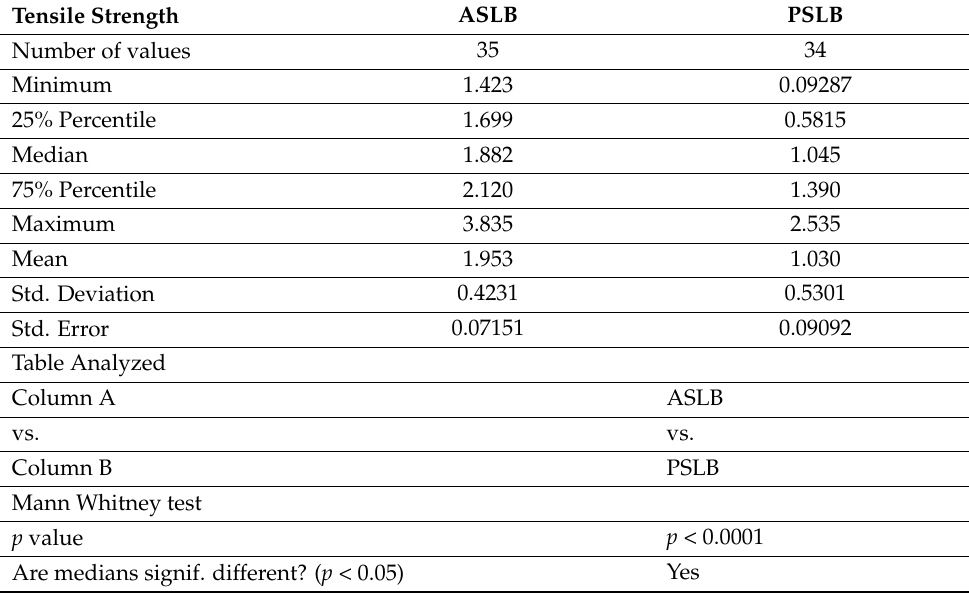
Table A1. Tensile strength: active vs. passive self-ligating